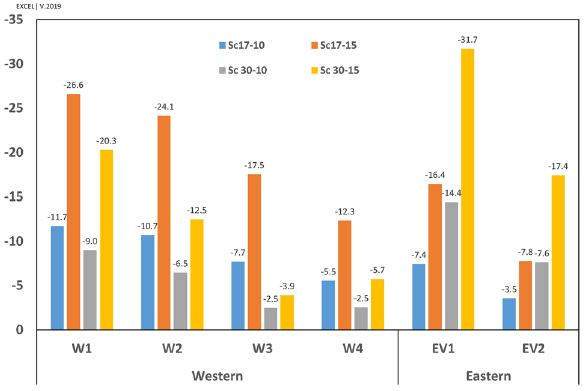
Figure 11. Pressure gradient in four scenarios for western and eastern